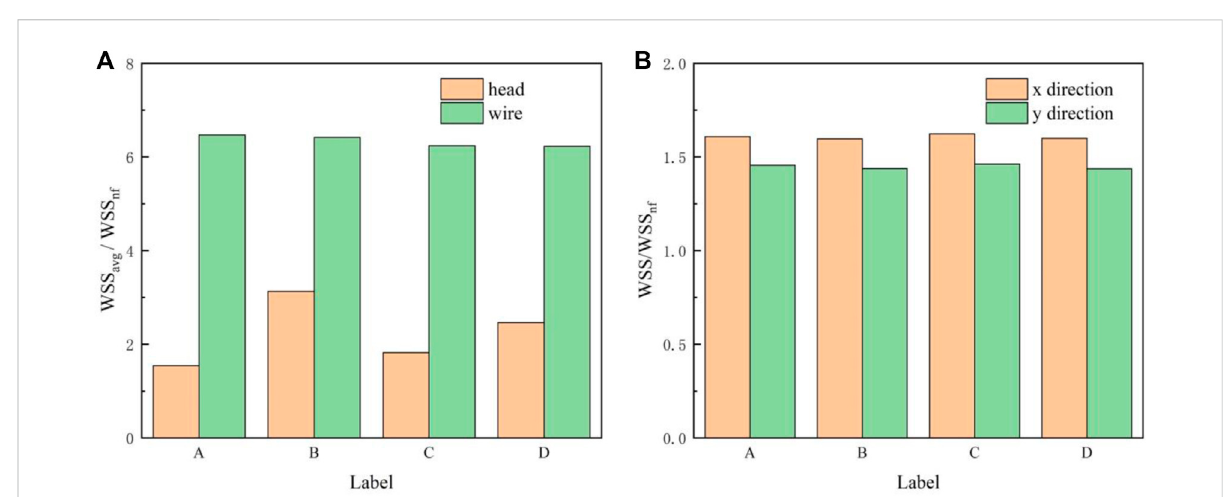
FIGURE 11 (A) WSS avg on the fi lter head or wire surface; (B) WSS max on the IVC surface in the x and y directions.